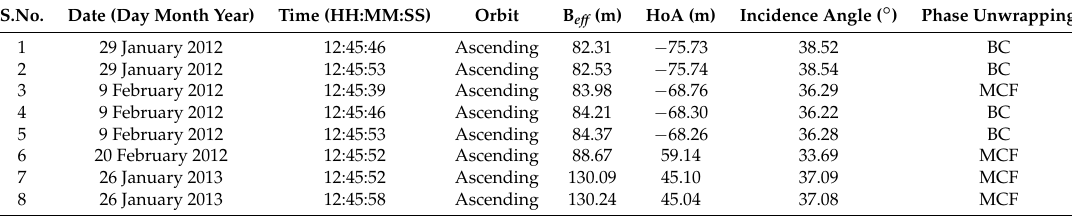
Table 1. The specifications of TanDEM-X images used in the study. These specifications include year, date and time of the TanDEM-X data acquisitions, orbital pass, effective baseline (B ef f ), height of ambiguity (HoA), incidence angle. The differential phase of TanDEM-X data was either unwrapped with Minimum Cost Flow (MCF) and Branch Cut (BC) algorithm (Section